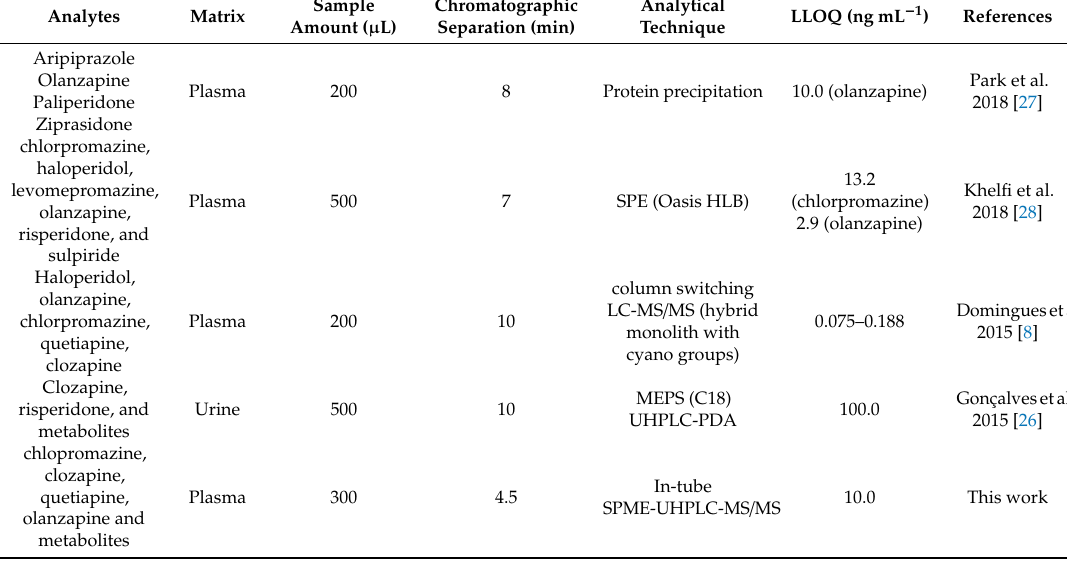
Table 5. Comparison of the in-tube SPME-UHPLC-MS / MS method with other counterparts to determine antipsychotics and their metabolites in biological samples.